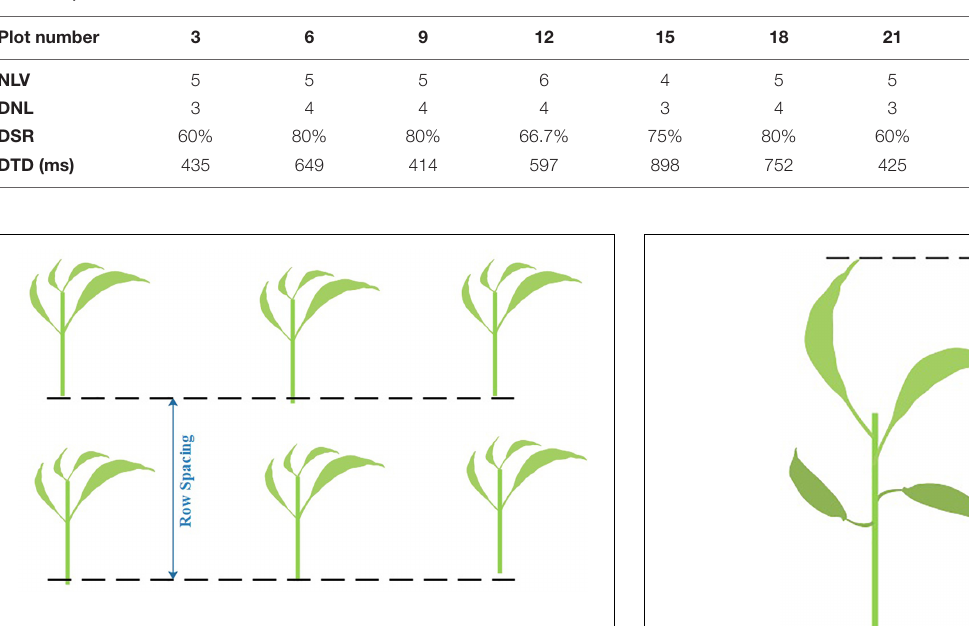
FIGURE 12 | Manual sampling method for row spacing. The dash lines are two adjacent local row-lines.